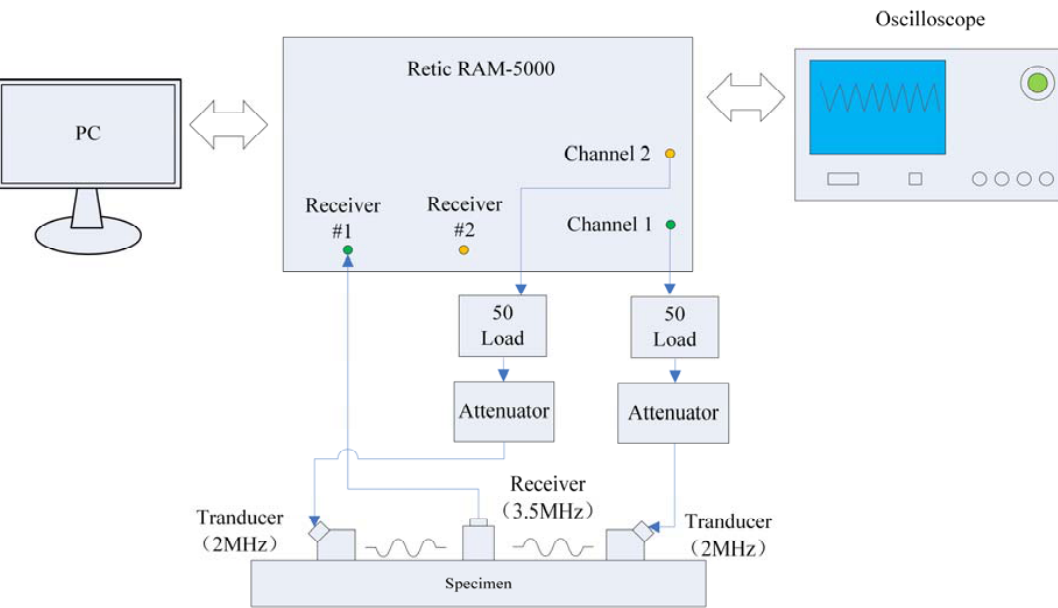
Figure 7. Schematic diagram of the testing system.